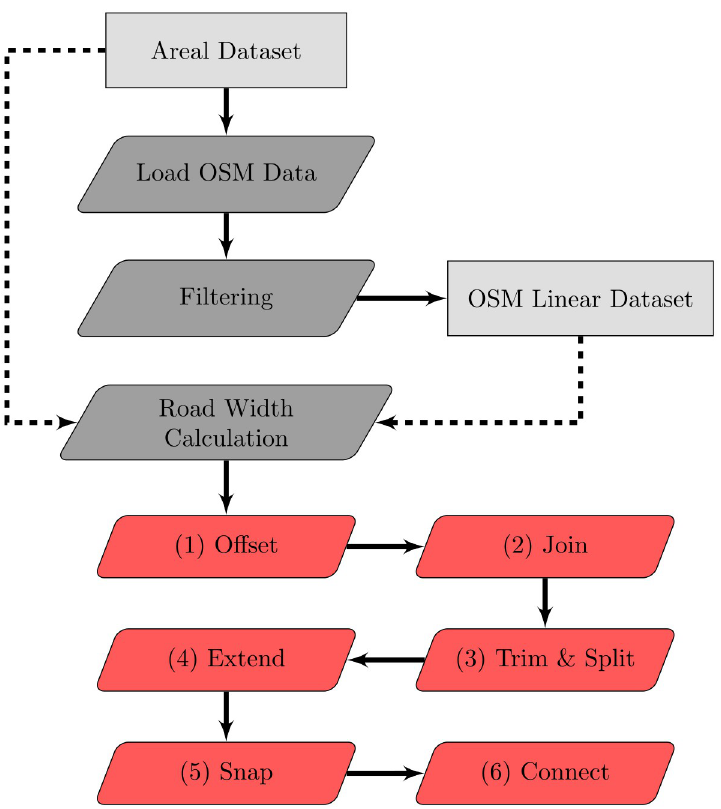
Fig 3. The main structure of the reconstruction methodology. Light grey rectangles represent data; dark grey trapeziums represent preprocessing steps; red trapeziums represent the iterations of our the main methodology.